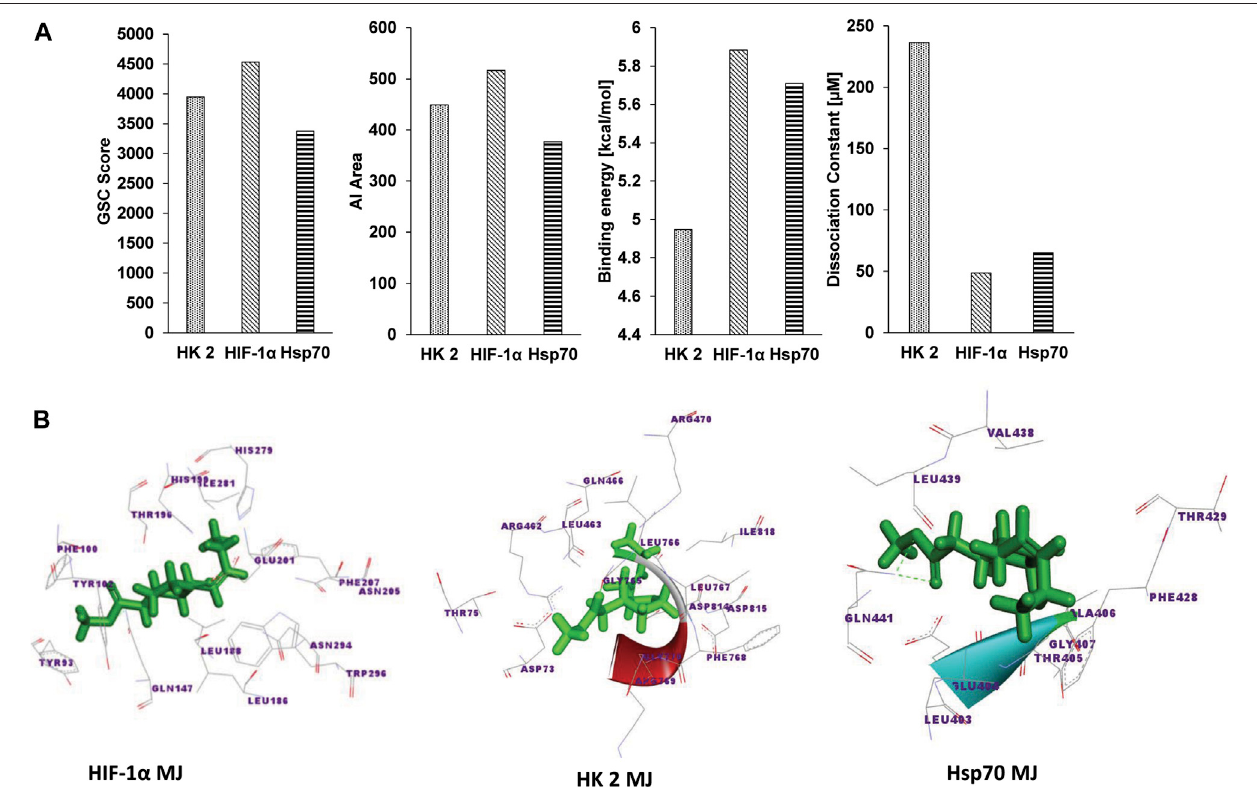
FIGURE 1 | Docking analysis of MJ to Hsp70, HK 2, and HIF-1 α . The docking strength of MJ to Hsp70, HK 2, and HIF-1 α was analyzed on parameters of GSC score,AIareacalculatedbyPatchDock,bindingenergy,anddissociationconstant(Kd)calculatedbyYASARA (A) .ThedockedcomplexeswerevisualizedbyDiscovery Studio 3.5, displaying the interaction of MJ to the indicated targets (B)